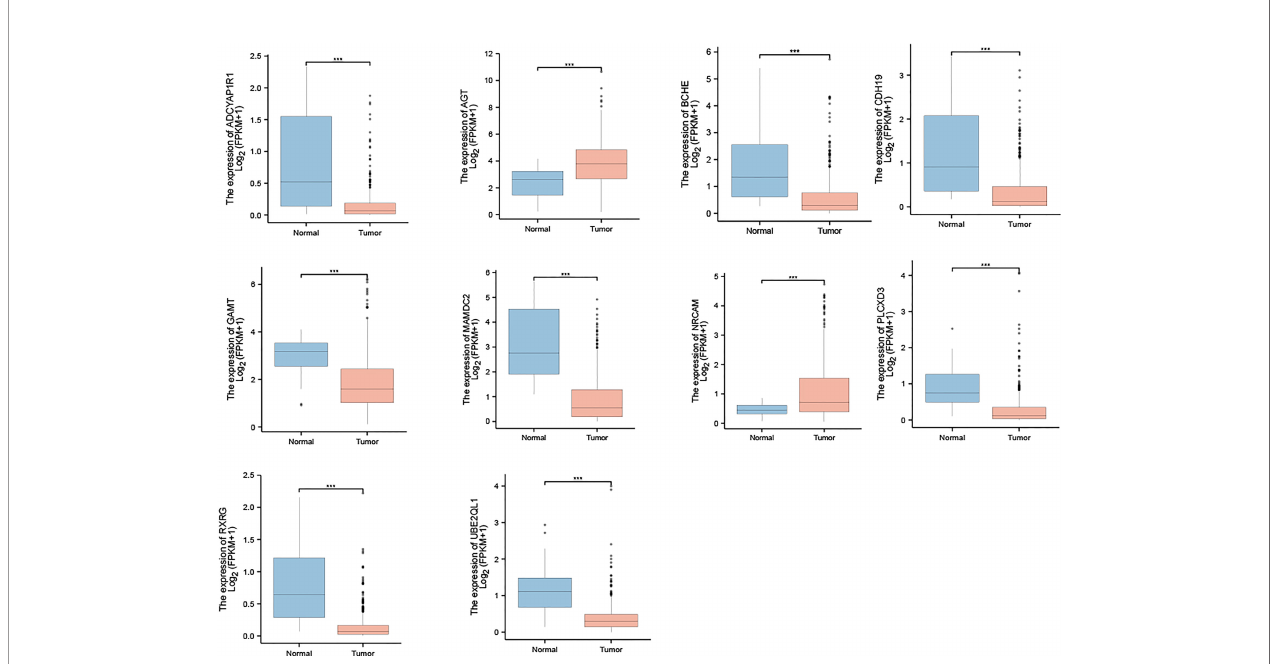
FIGURE 5 | Expression of 10 genes in gastric cancer and normal tissues. ***p < 0.001.